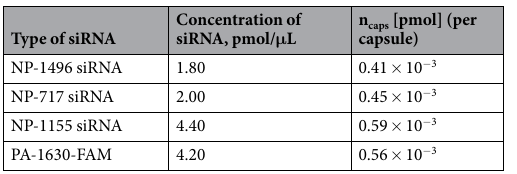
Table 1. Concentration and number of moles of siRNAs in SiO 2 -coated capsules. n caps – number of moles of siRNA per